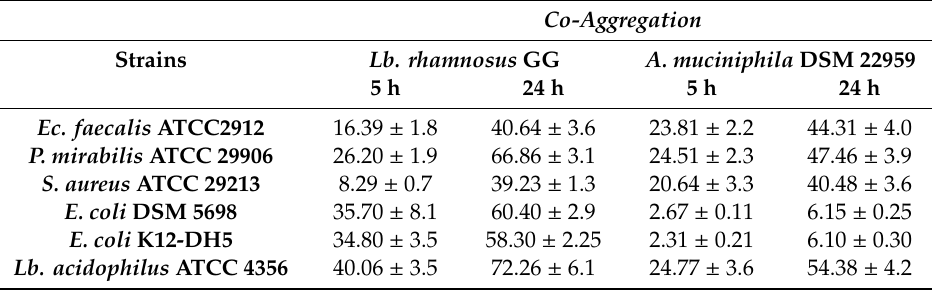
Table 5. Co-aggregation percentages of Lb. rhamnosus GG and A. muciniphila DSM 22959 with E. coli DSM 5698, E. coli K12-DH5, P. mirabilis ATCC 29906, Ec. faecalis ATCC 2912, S. aureus ATCC 29213, and Lb. acidophilus ATCC 4356 evaluated after 5 and 24 h of